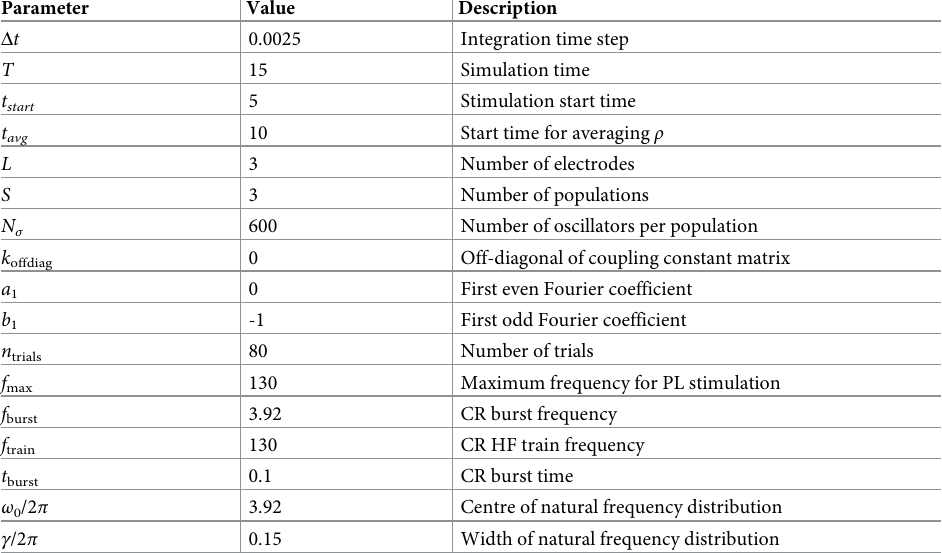
Parameter Value